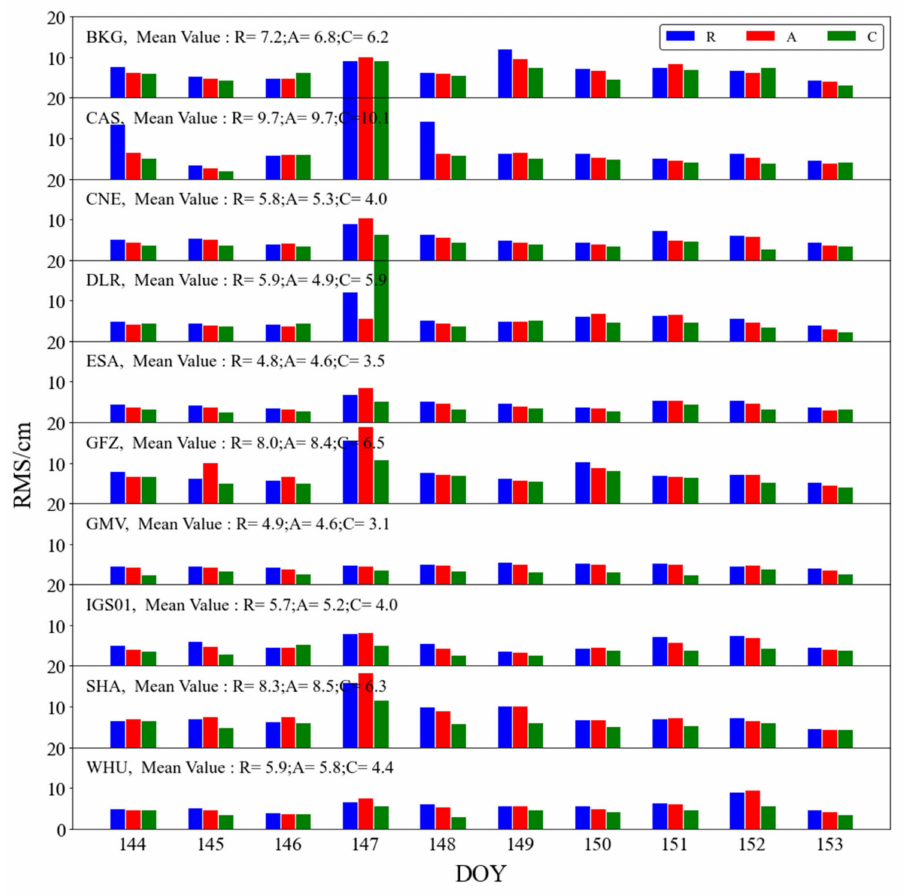
Figure 8. RMS of GRCC kinematic orbit products in the R, A, and C directions from JPL POE (the mean RMS of the orbit errors for each AC is shown in each